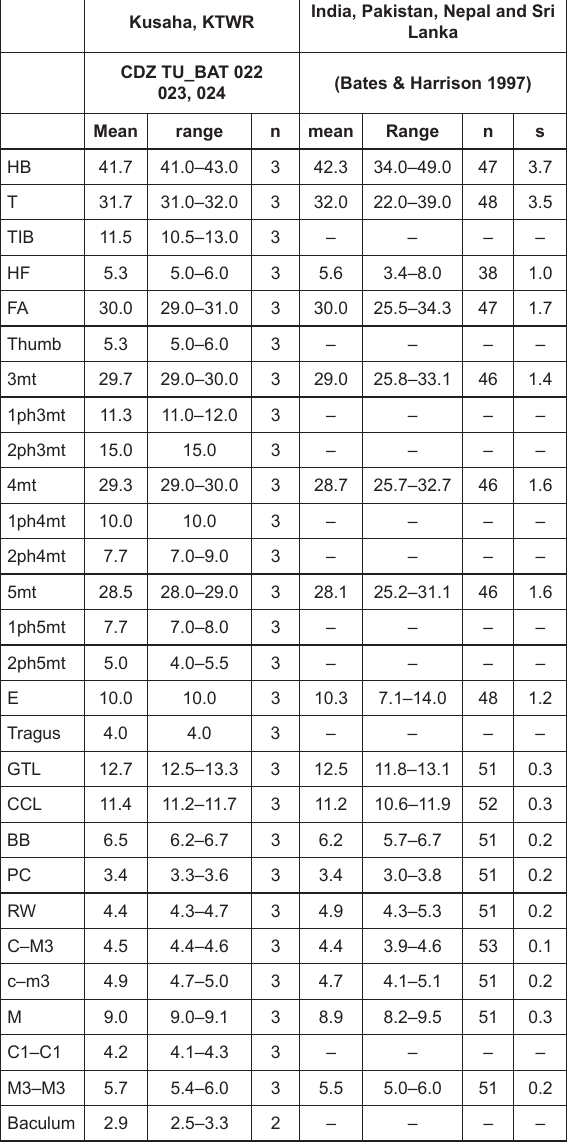
Table 2. External, cranial, and dental measurements (in mm) of Pipistrellus coromandra (CDZ TU_BAT 022;